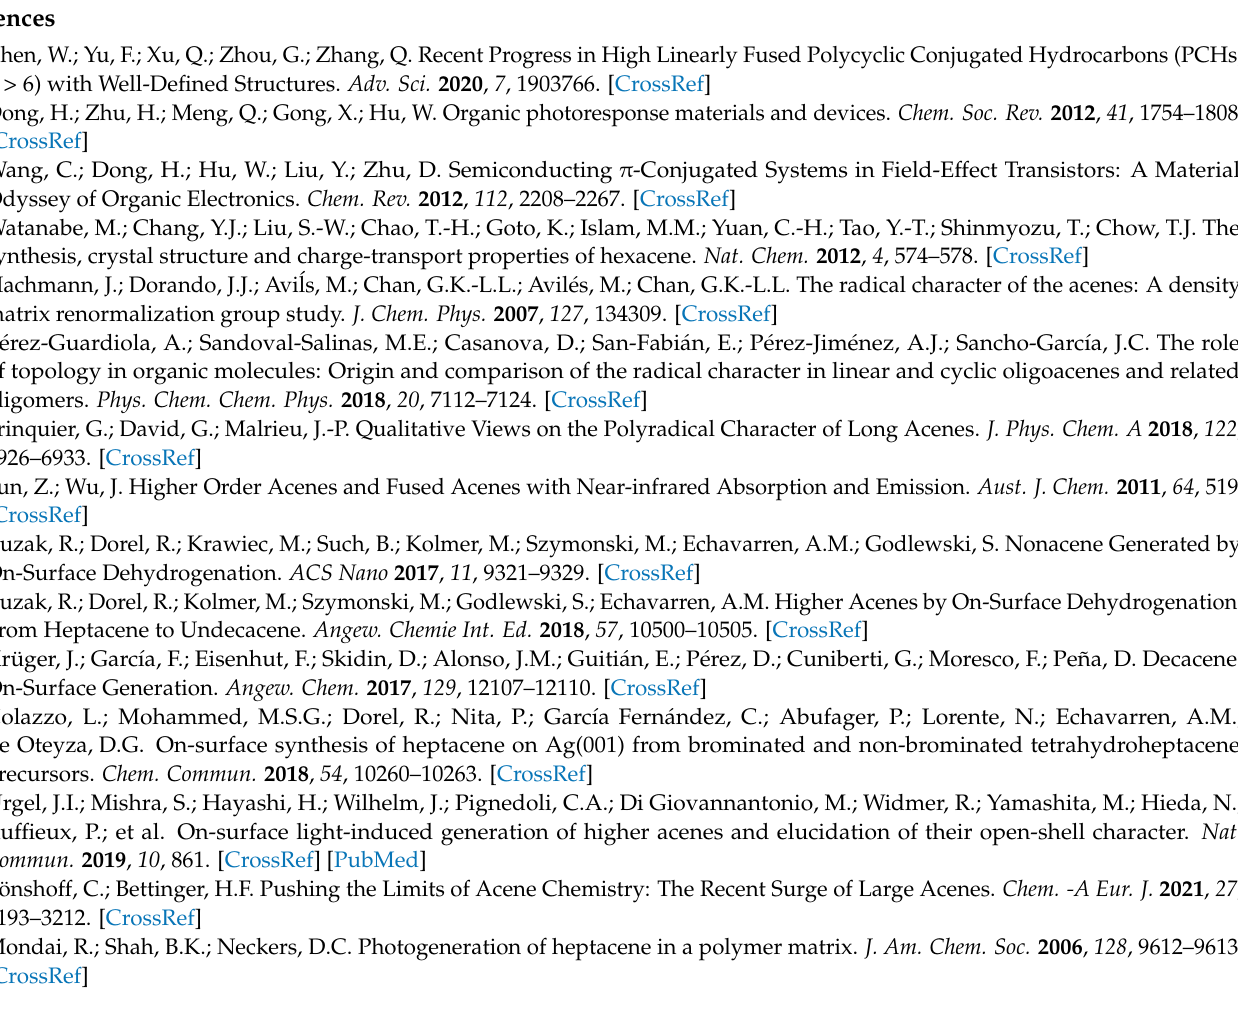
Table S5: Ground state energies of [n]-acenes and [n]-CCs ; Tables S6 and S7: Di- and poly-radical characters of [n]-acenes and [n]-CCs ; Table S8: Expression of BS frontier molecular orbitals as linear combination of CS frontier molecular orbitals; Table S9: Excitation energies of the L a state of [n]- acenes ; Table S10: Excitation energies of the DE state of [n]-acenes ; Table S11: Excitation energies of the L a and DE states for even [n]-CCs ; Figure S1: Frontier molecular orbitals of [n]-acenes ; Figure S2: Frontier molecular orbitals of even [n]-CCs ; Figure S3: Frontier molecular orbitals of odd [n]-CCs ; Figure S4: Energy trend of [n]-acenes’ frontier molecular orbitals; Figure S5: Relationship between N FOD and y 0 ; Figure S6: Relationship between N FOD and y 1 ; Figure S7: Crossing between the L a and DE state calculated at DFT/MRCI level with the original parametrization; Cartesian coordinates of all the optimized